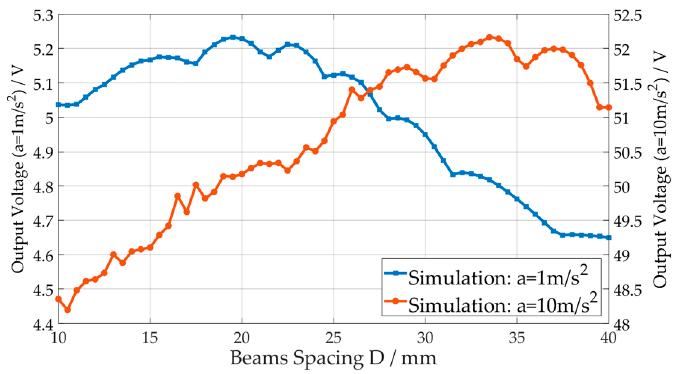
Figure 12. Output voltage at different D with B r = 0.12 T based on simulation and experiment.